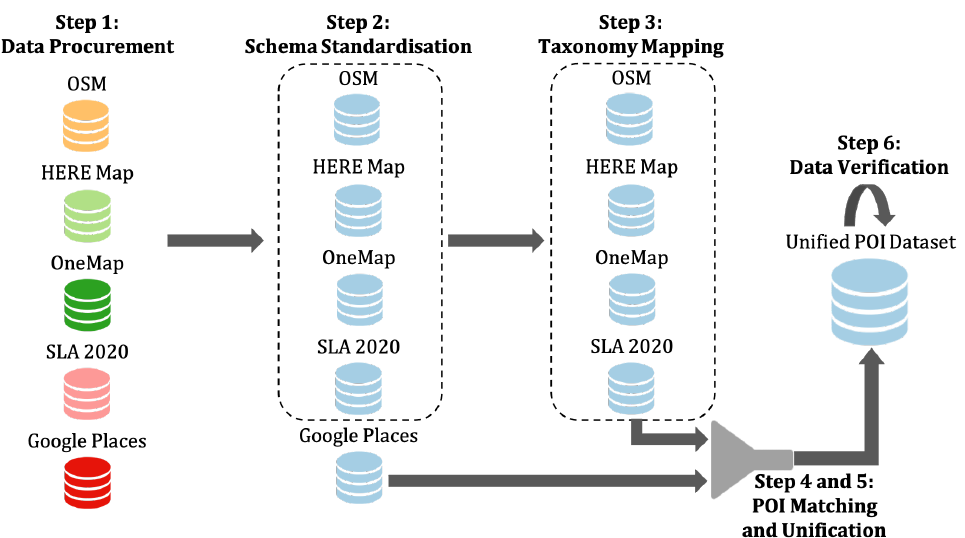
Figure 5. Application of the proposed POI conflation framework within the study area of Tampines. POIs obtained from Google Places are not required to go through the Taxonomy Mapping step as the Google Places’ place type taxonomy was chosen as the default taxonomy in this